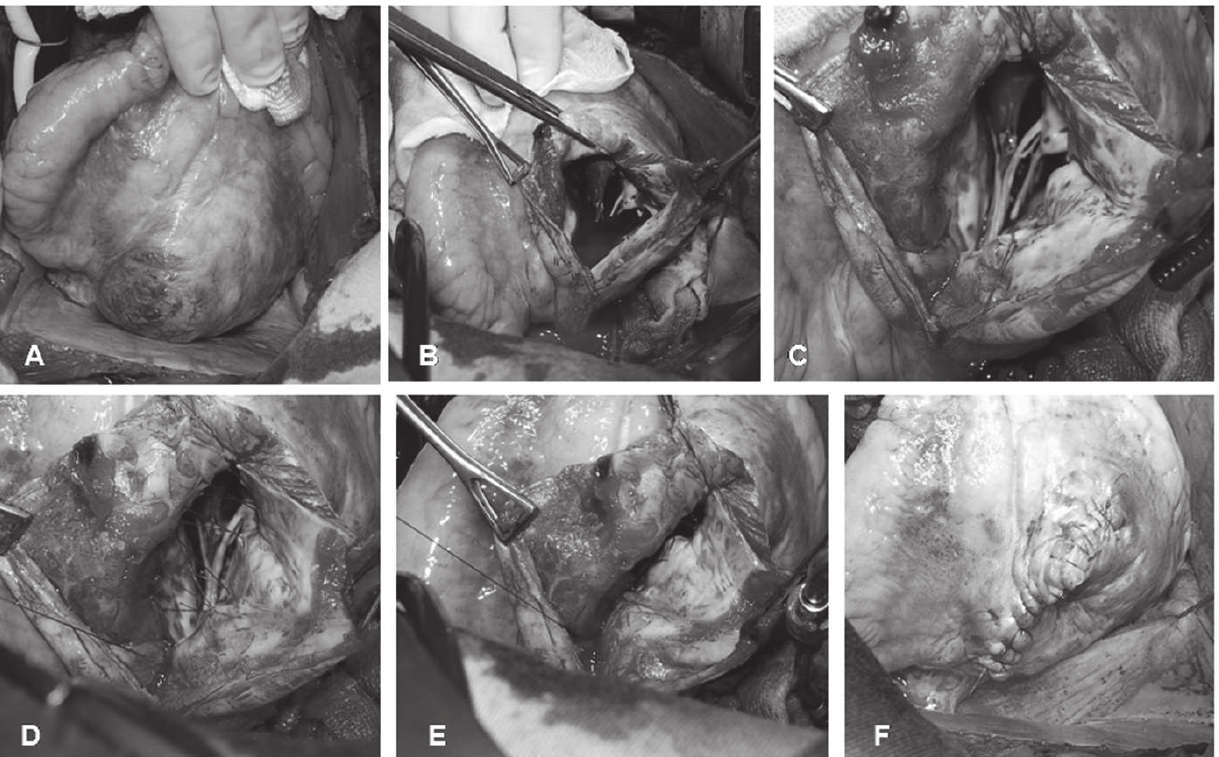
Fig. 3 - Stepwise sequence of the operative technique; aneurysm of the left ventricular inferior